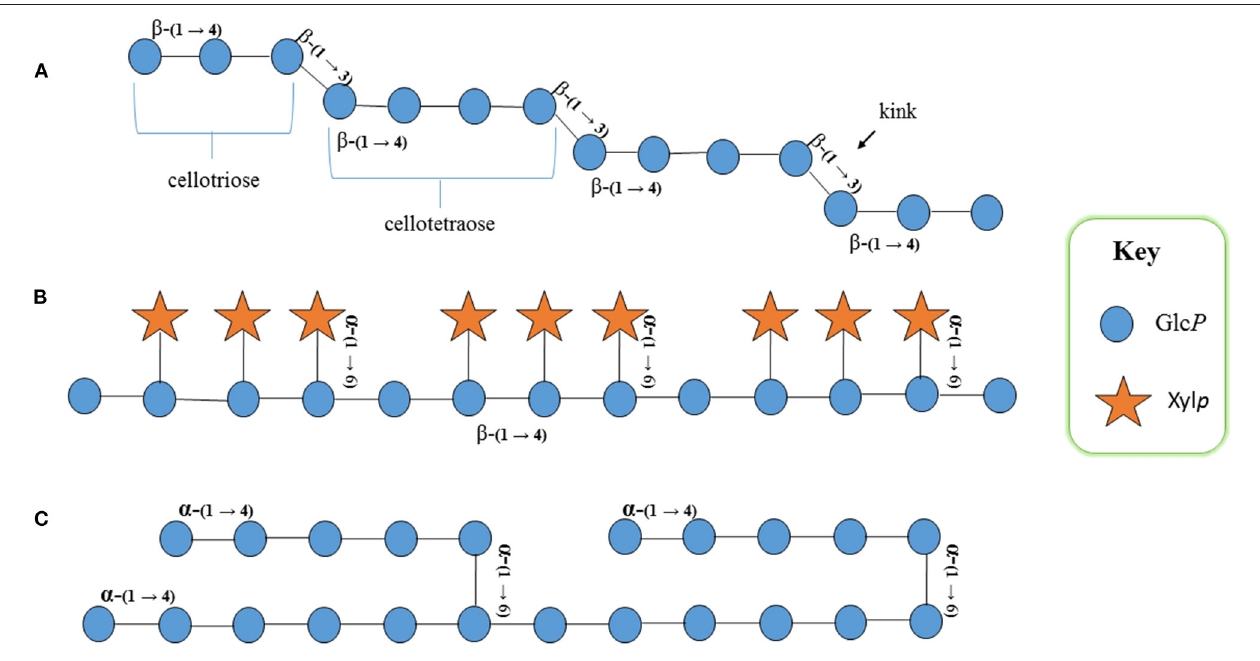
FIGURE 2 | Schematic structural representation of rice (A) mixed linkage (1,3;1,4)- β -D-glucan (MLG): cellotriose and cellotetraose with β -(1 → 4) linkages are interconnected with β -(1 → 3) linkages that produce a kink in the structure, conveying properties different to other glucans in the cell wall, (B) xyloglucan: β -(1 → 4)- D -glucan backbone substituted with α -(1 → 6) xylosyl residues; the fourth glycosyl residue on the backbone remains unsubstituted, and (C) starch: α -(1 → 4)- D -glucan backbone that remains unbranched in amylose and branched in amylopectin. Glc P , glucopyranosyl residue; Xyl P , xylopyranosyl residue.